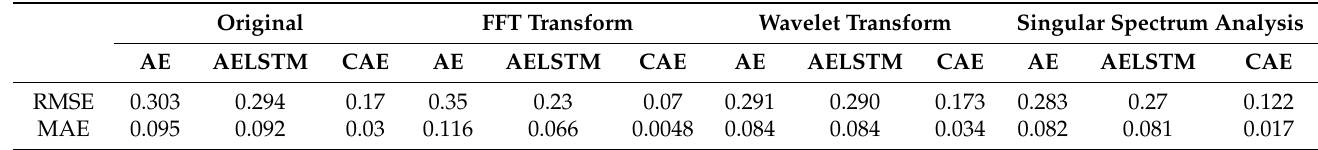
Table 3. The results of deep learning model learning according to each reconstruction data.